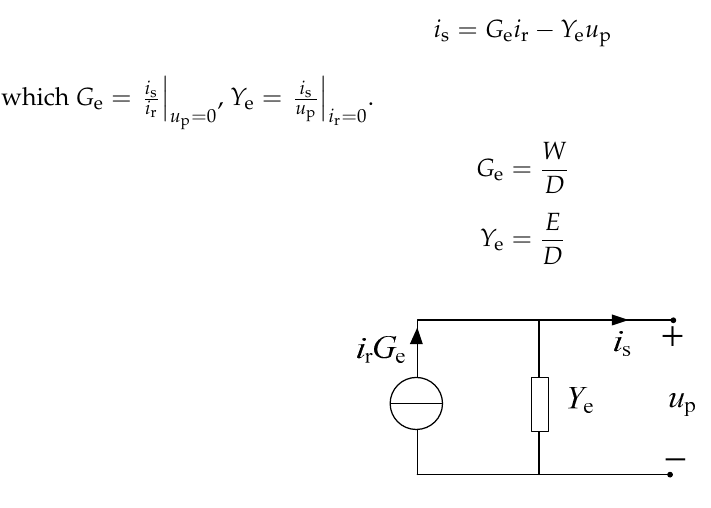
Figure 4. Inverter Norton model.